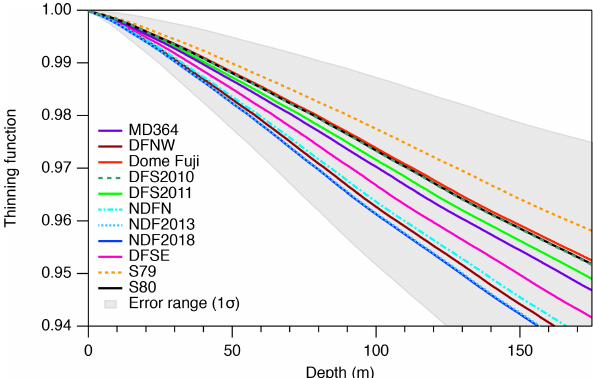
Figure 5. Thinning function with 1 σ uncertainty. The data for Dome Fuji is from Parrenin et al.